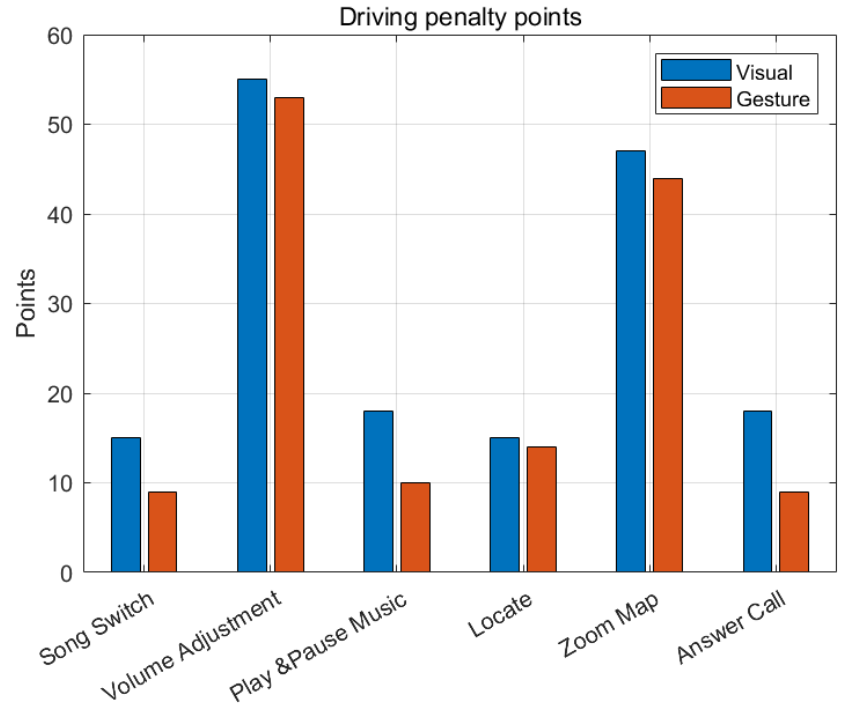
Figure 10. Driving penalty points. V stands for Visual Interface. G stands for Gesture